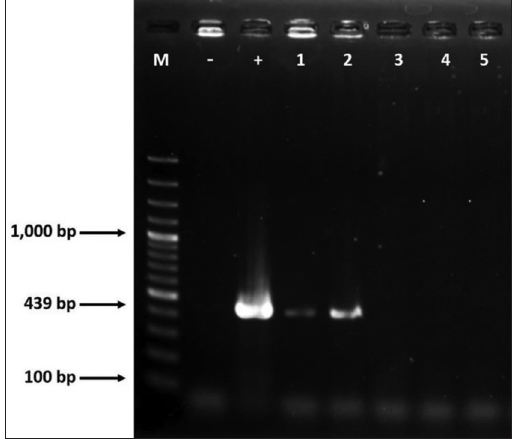
Figure-2: Gel electrophoresis detected bla M=Ladder or marker, −=Negative control ( Escherichia coli ATCC 25922), +=Positive control (laboratory reference), 1= E. coli isolate No. W 11.2 A, 2= E. coli isolate No.